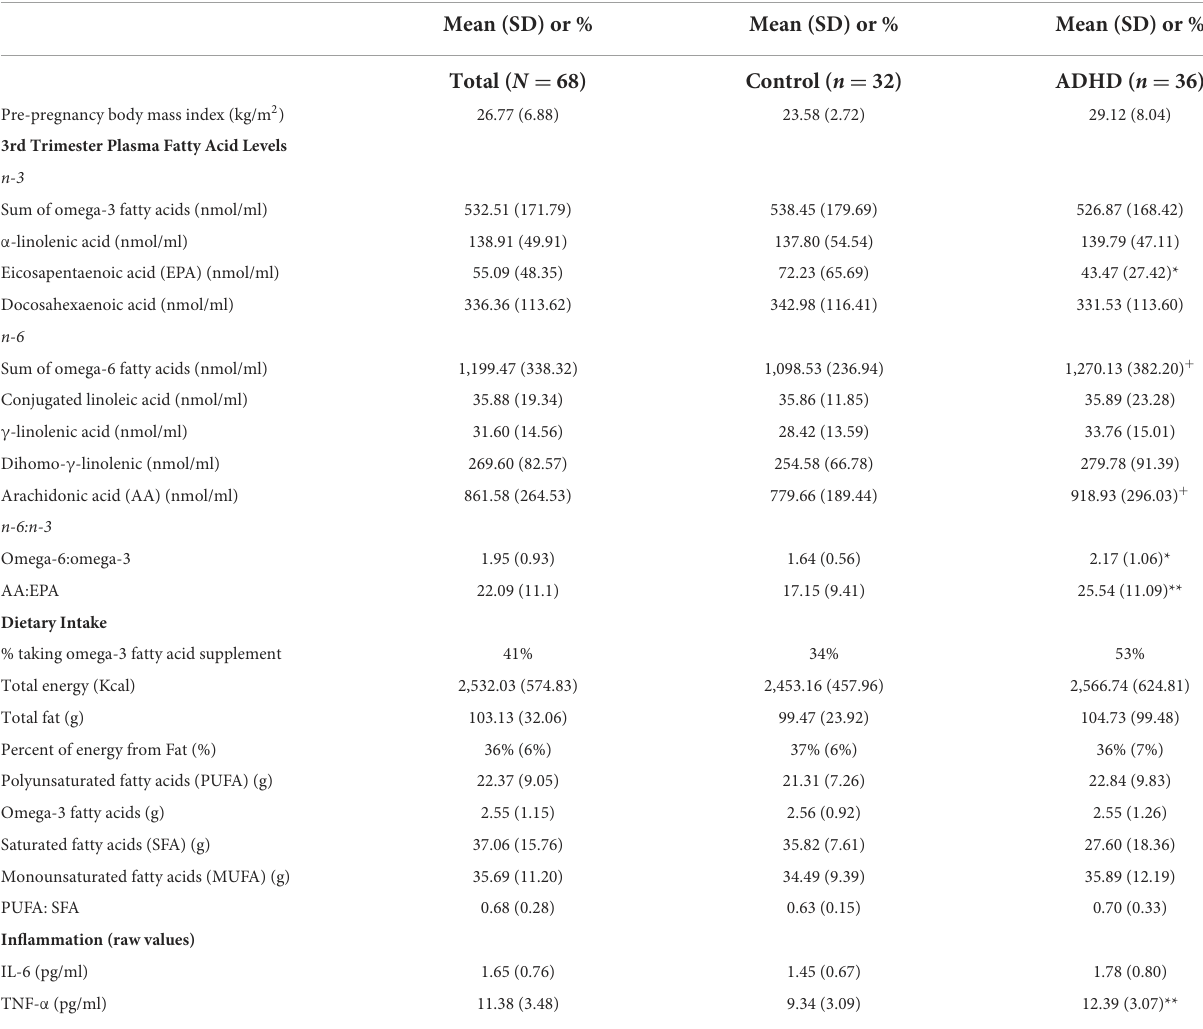
TABLE 2 Means for all study variables ( N =